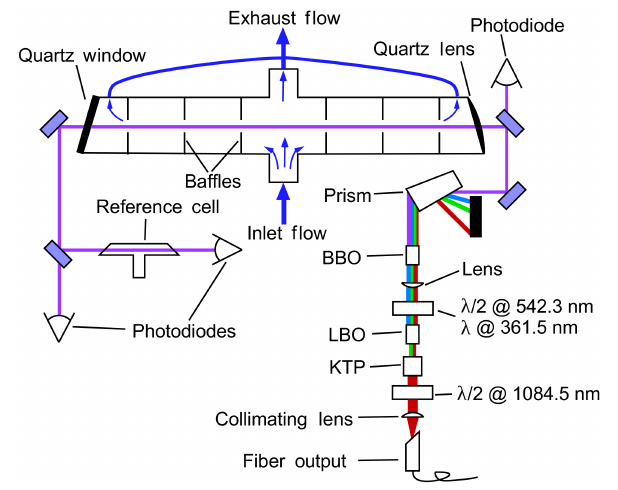
Figure 4. Schematic of the free-space optical